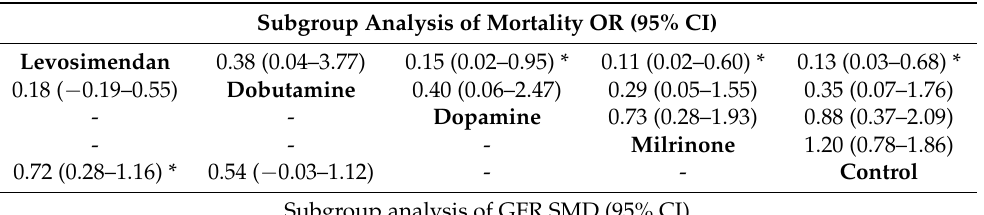
Subgroup analysis of GFR SMD (95%